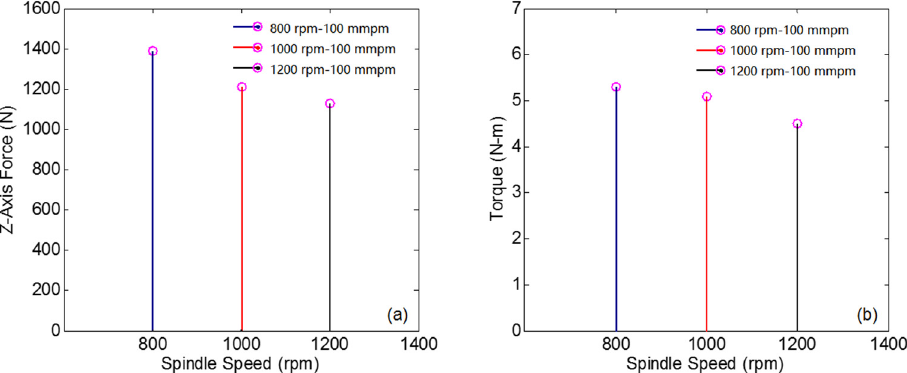
Figure 7. The influence of spindle speed: ( a ) the impact of spindle speed on the axial force; and ( b ) the influence of spindle speed on torque.